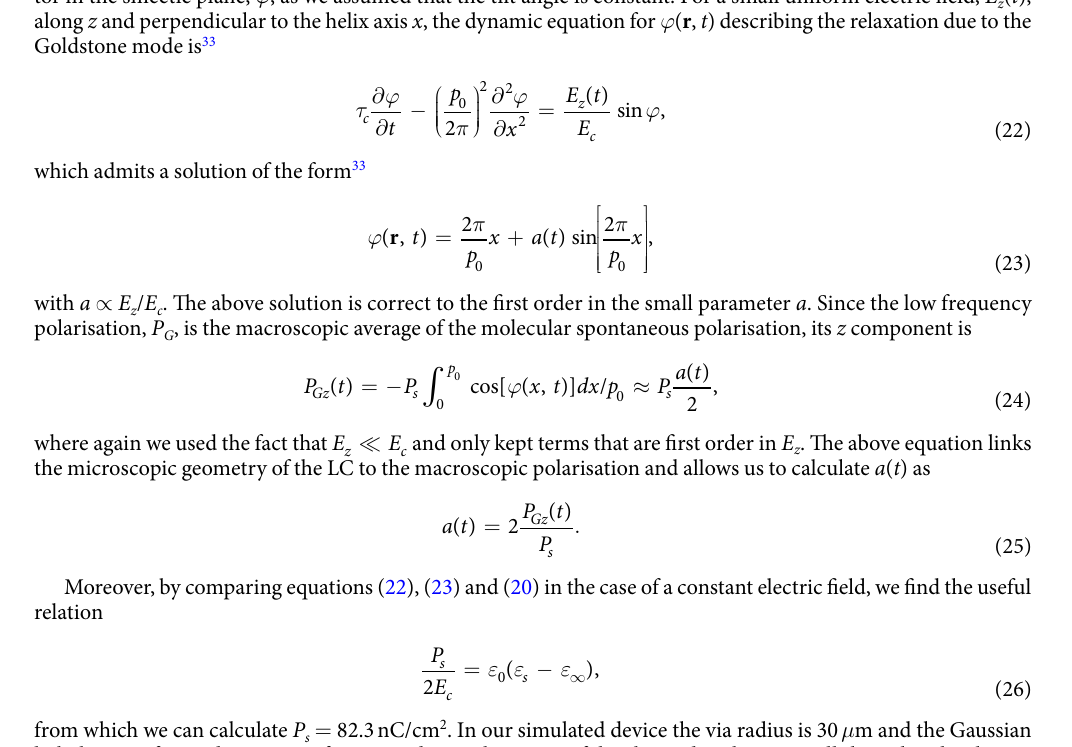
ship between voltage and reflectance, as well as a large change in reflectance per applied Volt. Based on prelimi- nary experimental work, the most accurate way of measuring such reflectance changes in practice is by using an optical fibre pigtailed to a focusing GRIN lens. This is therefore the system we simulate. Reflectance from the bottom of a single optrode is calculated in COMSOL using the 2D geometry shown in Fig. 5 and the “wave optics” module. The problem is solved in the frequency domain at each time step solved for in the previous part, where P G was calculated. The frequency, f = 193414.5 GHz, is in the optical region and it is related to the wavelength of the incident light, λ = 1.55 μ m. The size of the simulation domain in the helix axis direction x is 40 μ m, large enough to fully describe the Gaussian beam. Periodic boundary conditions have been imposed at x = ± 20 μ m. From bottom to top, the simulation domain includes the top of the glass substrate, described by an isotropic refractive index n g = 1.52, the LC layer and the bottom of the gold optrode, described as gold coated glass in order to reduce the computational complexity. In particular, the gold coating is simulated as a “transition boundary condition” with a layer thickness of 60 nm and the appropriate wavelength dependent permittivity for the gold 34 . We have checked that, within the numerical errors, the reflectivity of such a mirror is indistinguishable from the expected value for bulk gold. More details about this boundary condition are given in the supplementary